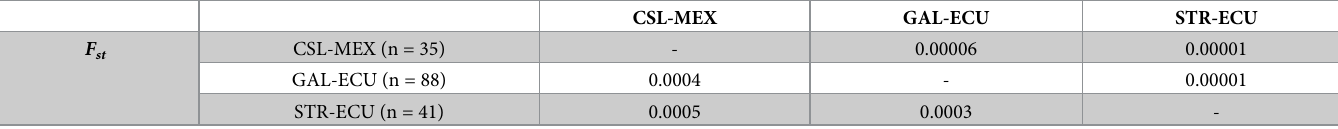
Table 2. Pairwise genetic differentiation analyses for the yellowfin tuna among sampling